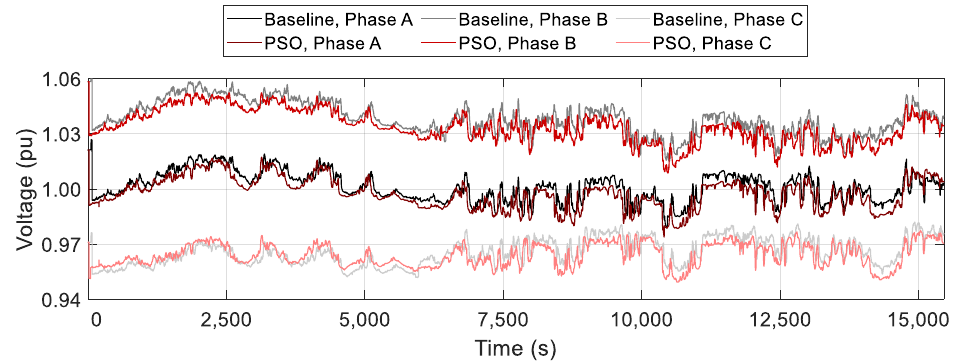
Figure 8. Comparison of Phase Voltages for PV Inverter 1 at the PCC for Baseline and PSO.